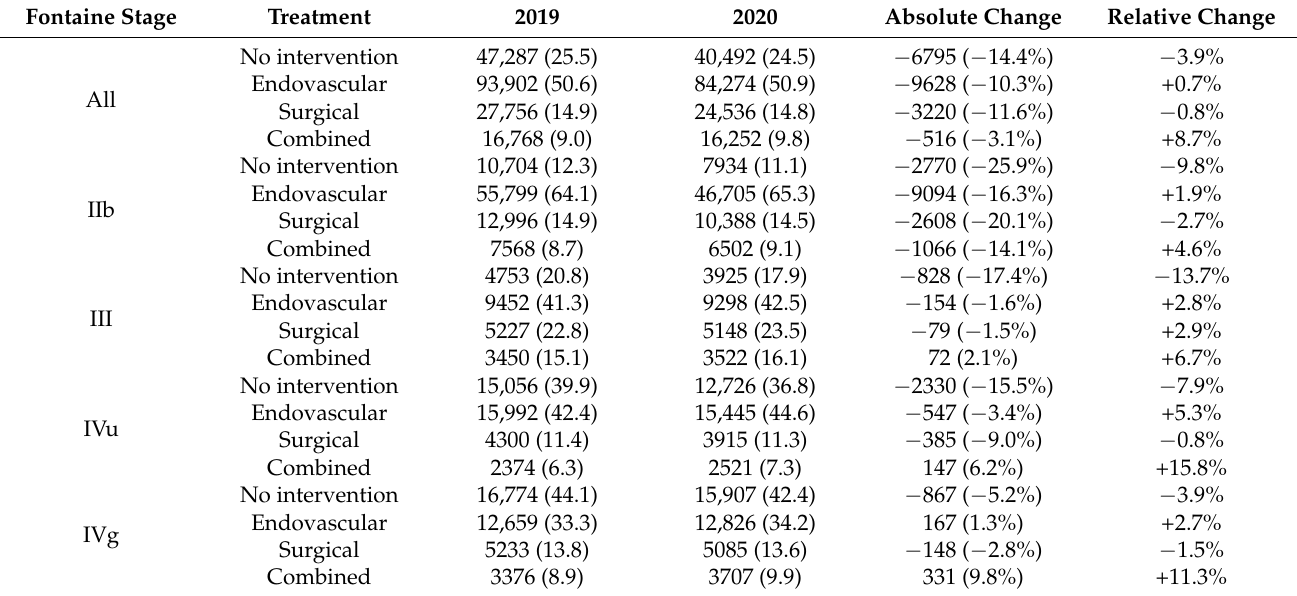
Table 5. Type of treatment of patients hospitalized due to peripheral artery disease in 2019 and